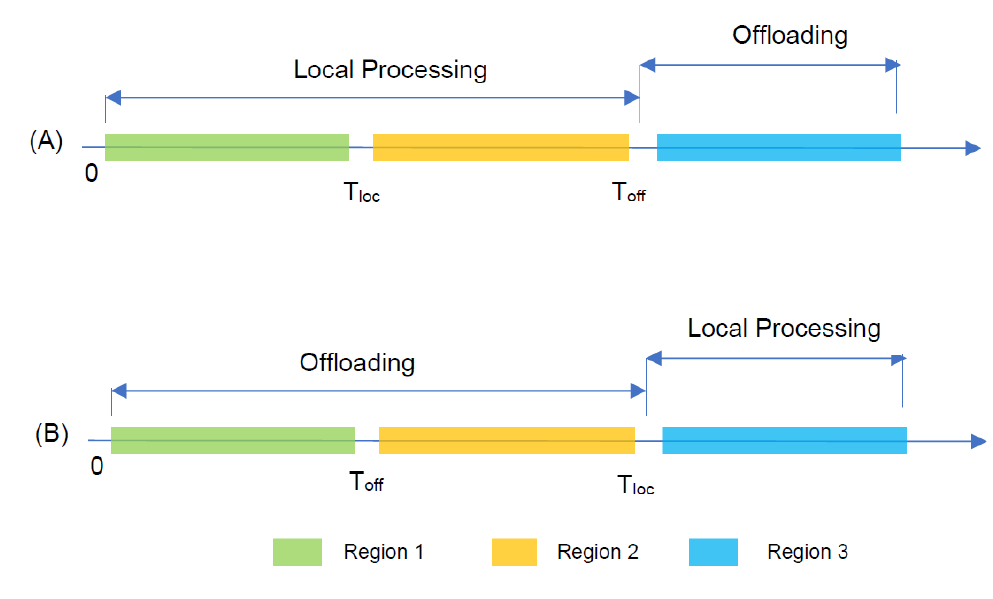
Figure 4. Local and offloading computation thresholds. ( A ) T of f > T loc ( B ) T loc > T of f .